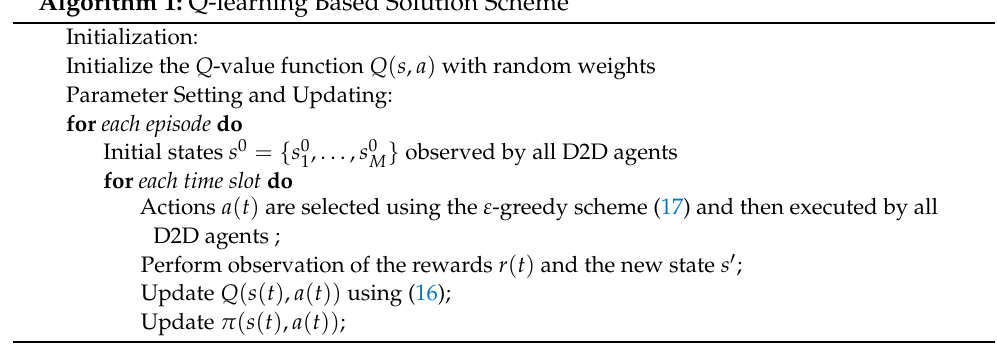
Algorithm 1: Q-learning Based Solution